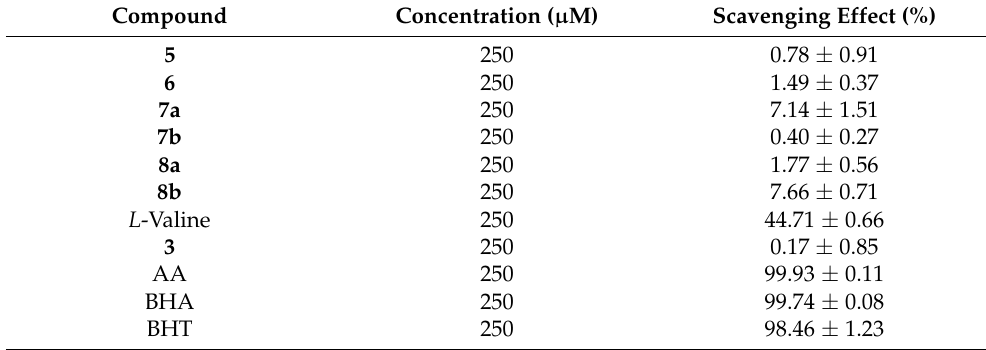
Table 7. Results of the evaluation of the scavenging effect of the compounds analyzed by the ABTS method.